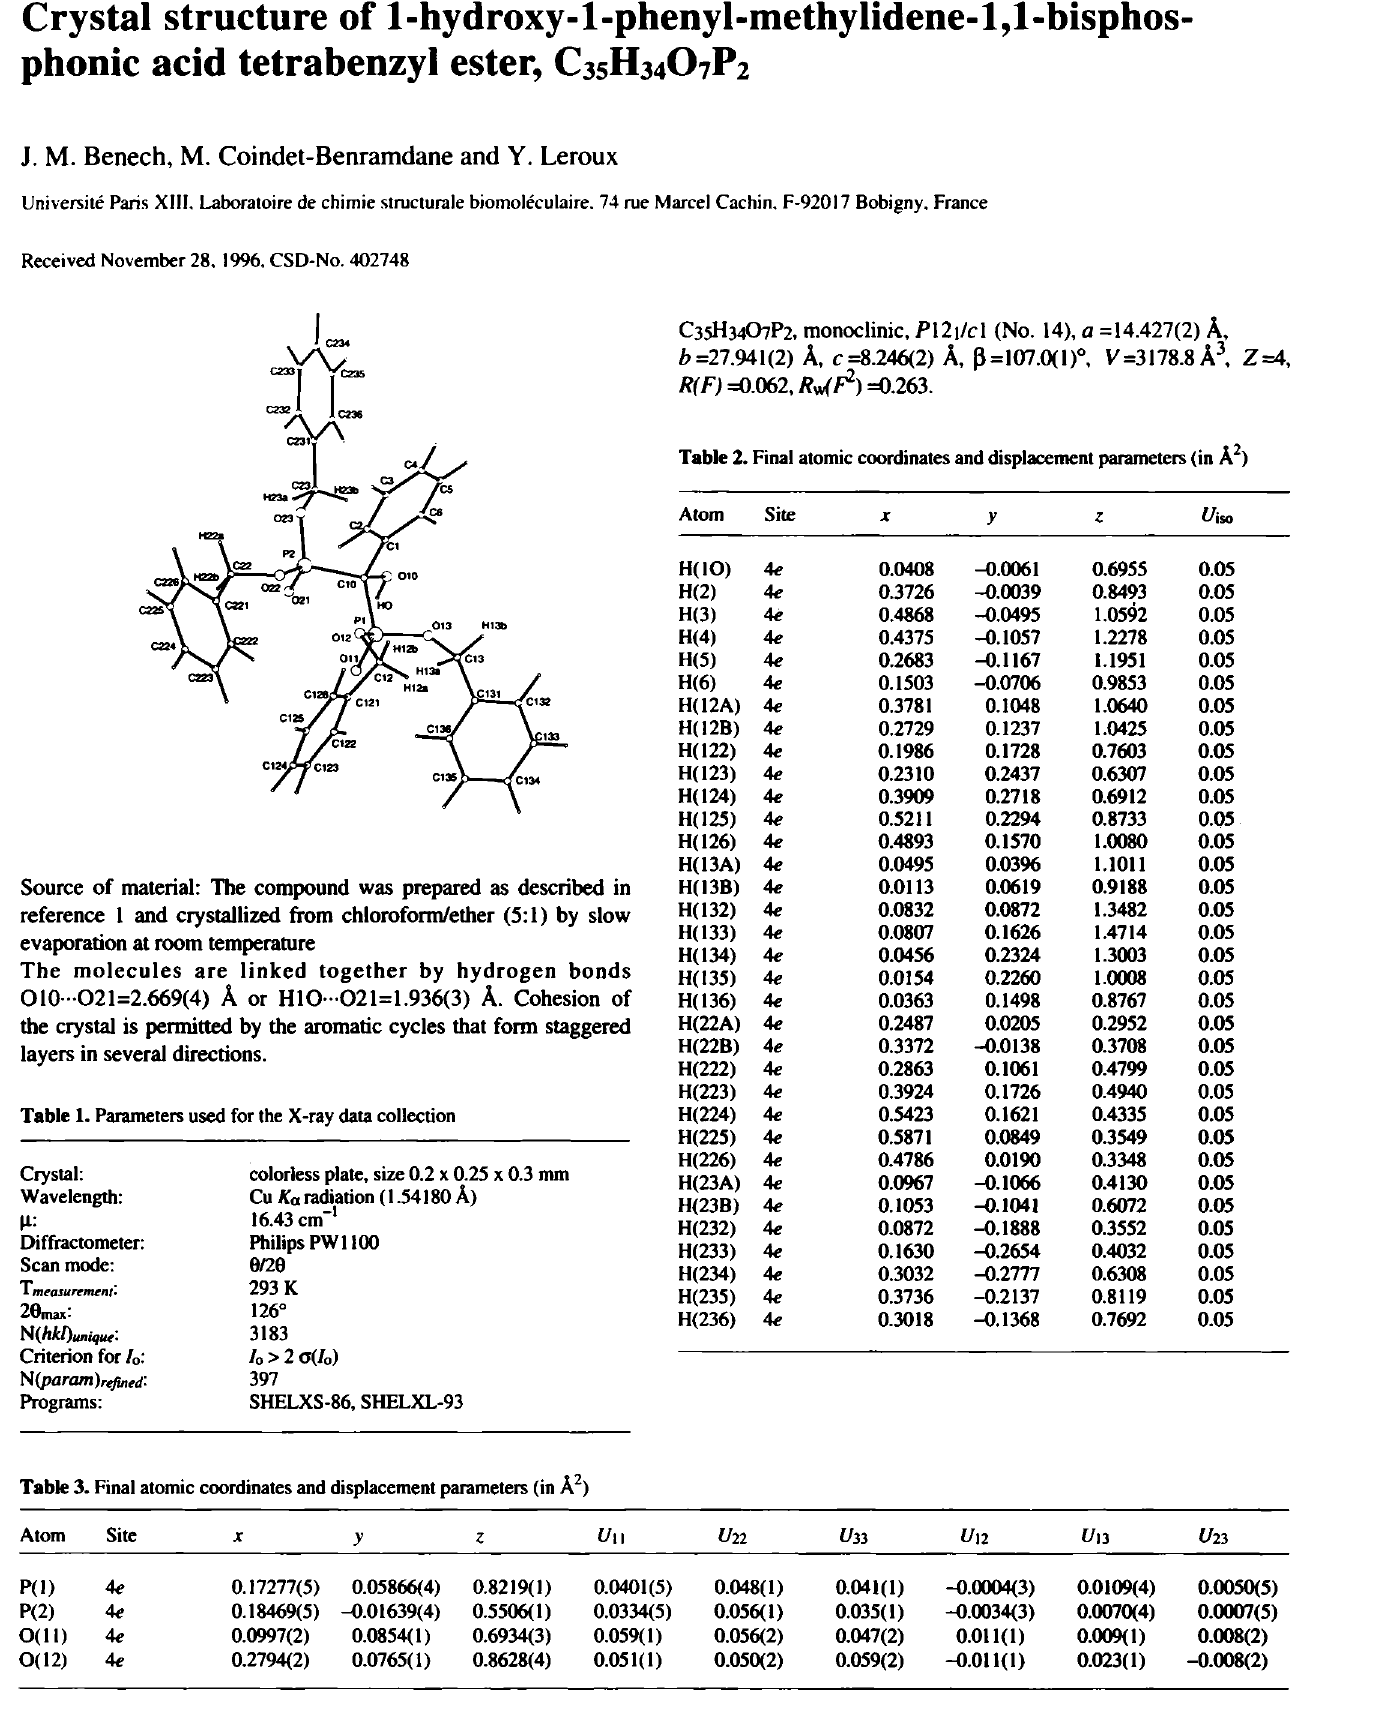
Table 3. Final atomic coordinates and displacement parameters (in Â 2